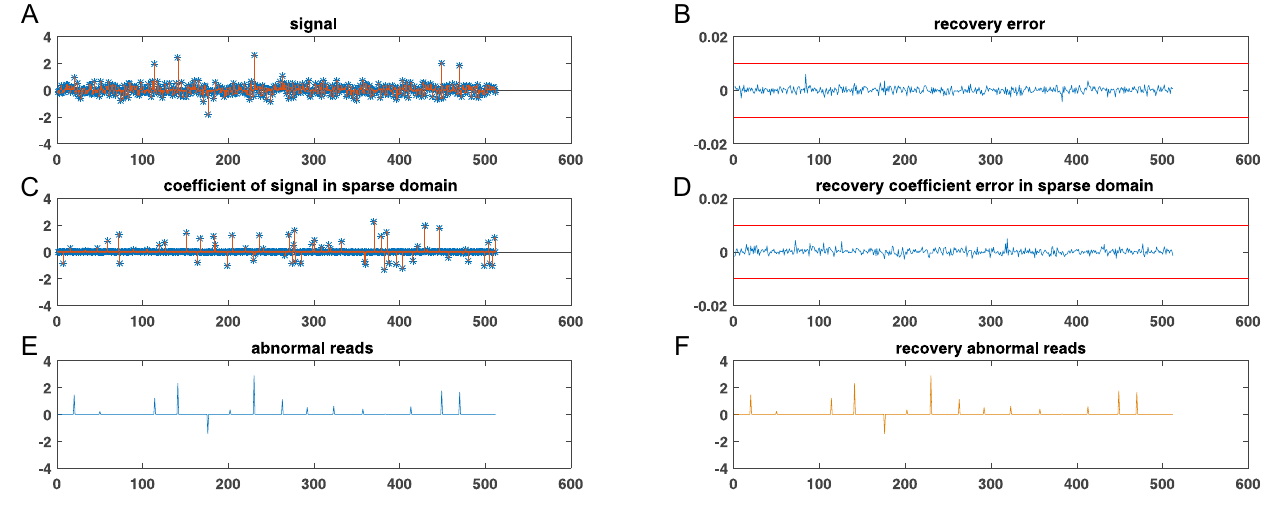
Figure 5. ( A ) Original signal and recovery signal; ( B ) recovery error of reconstruction; ( C ) reconstruc- tion sparse domain coefficient; ( D ) recovery error of sparse domain coefficient; ( E ) abnormal events of a wireless sensor network; ( F ) the recovery result of abnormal